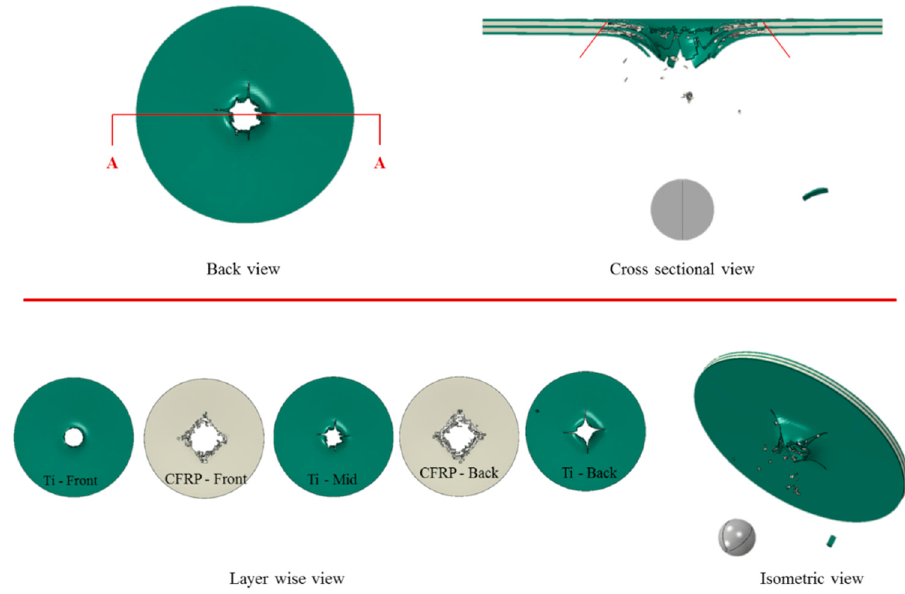
Figure 8. Laminate and layer wise damage shapes of the TFML-3/2.